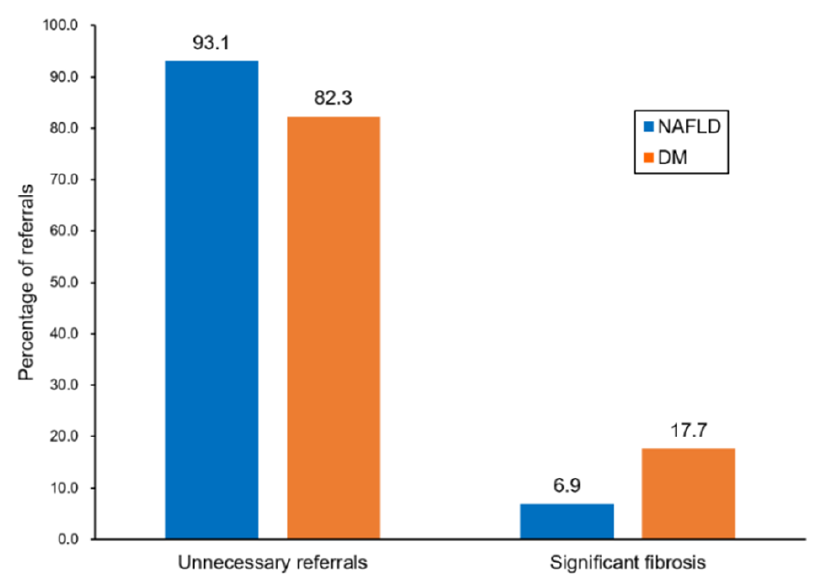
Figure 5. Evaluation of patients referred to secondary care .